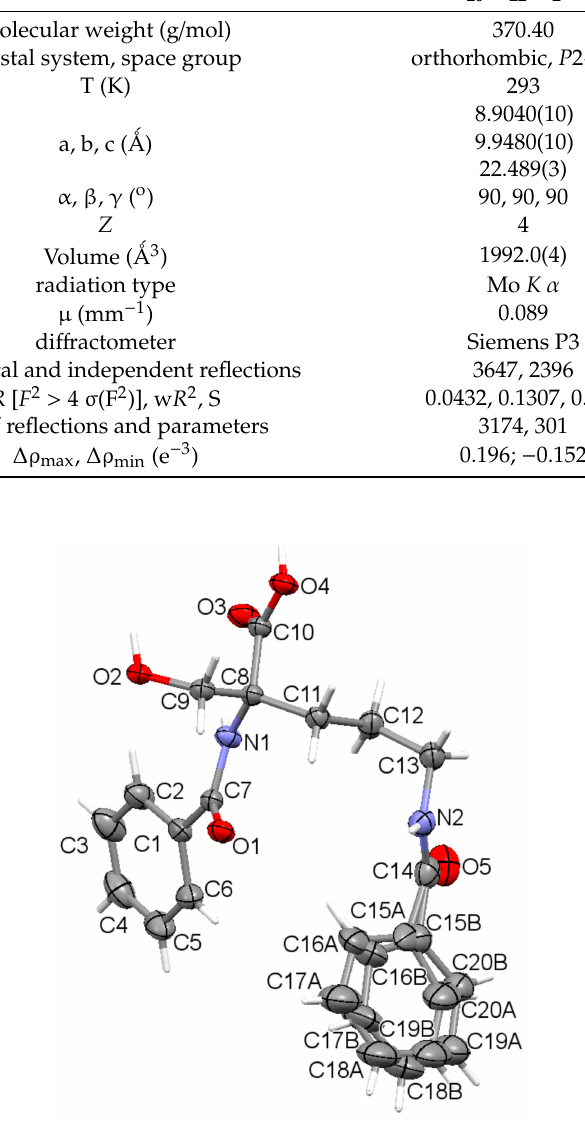
Table 1. Crystallographic data and structure refinement parameters for 1 .